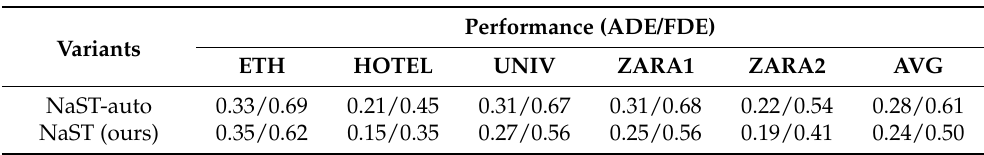
Table 4. The comparation of non-autoregressive and autoregressive inference pattern on ETH and UCY datasets of ADE/FDE metrics (the lower numerical result is better).